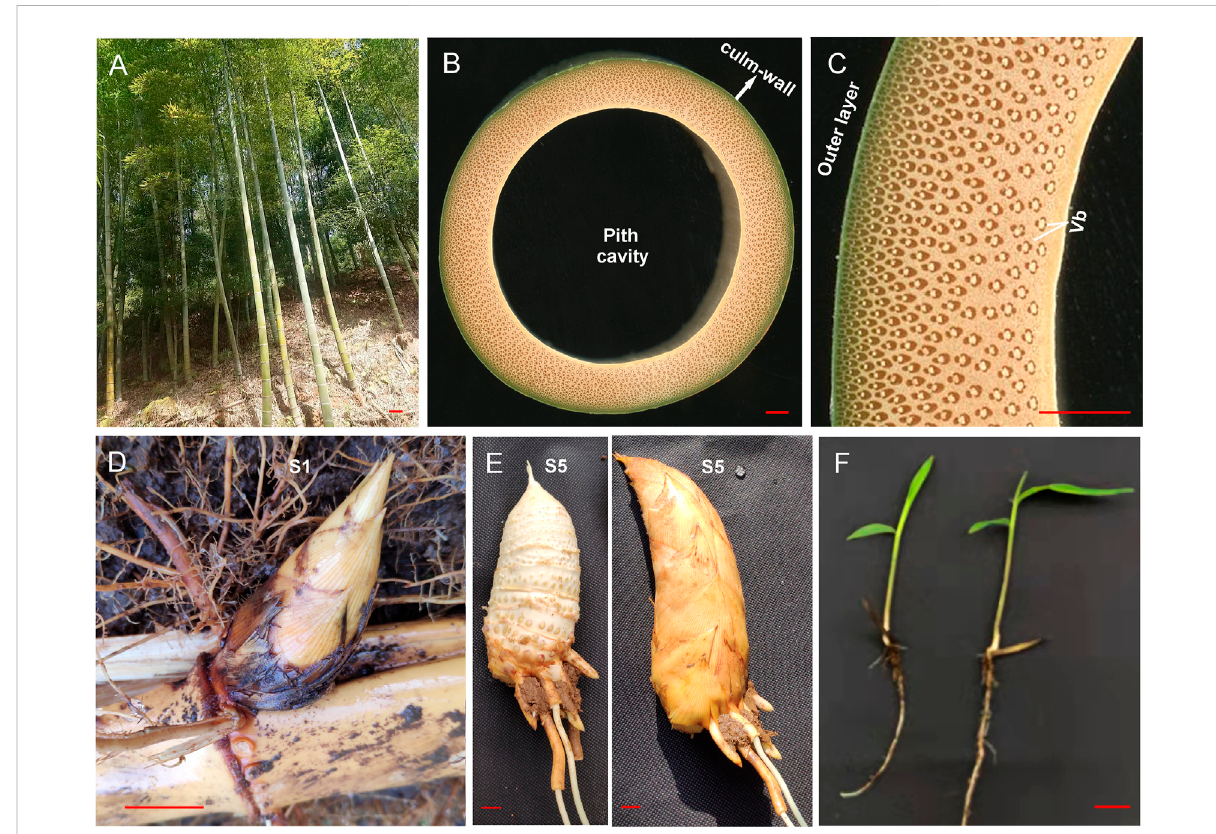
FIGURE 1 Phenotypes of aboveground culms, underground shoots, and seedlings of Moso bamboo. (A) Aboveground culms of two-year-old wild-type Moso bambooplants. (B) Cross-sections ofthethird internodeofthemature culm ofwild-type Moso bamboo. (C) Enlarged imageof thelocal culm wall in (B) . (D) Underground shoots collected at the S1 stage. (E) Underground shoots collected at the S5 stage; the left image shows the edible bamboo shoot with the shell removed. (F) Phenotype of two-month-old Moso bamboo seedlings. The scale bar is 10 cm in (A) and 1 cm in the other panels. Vb, vascular